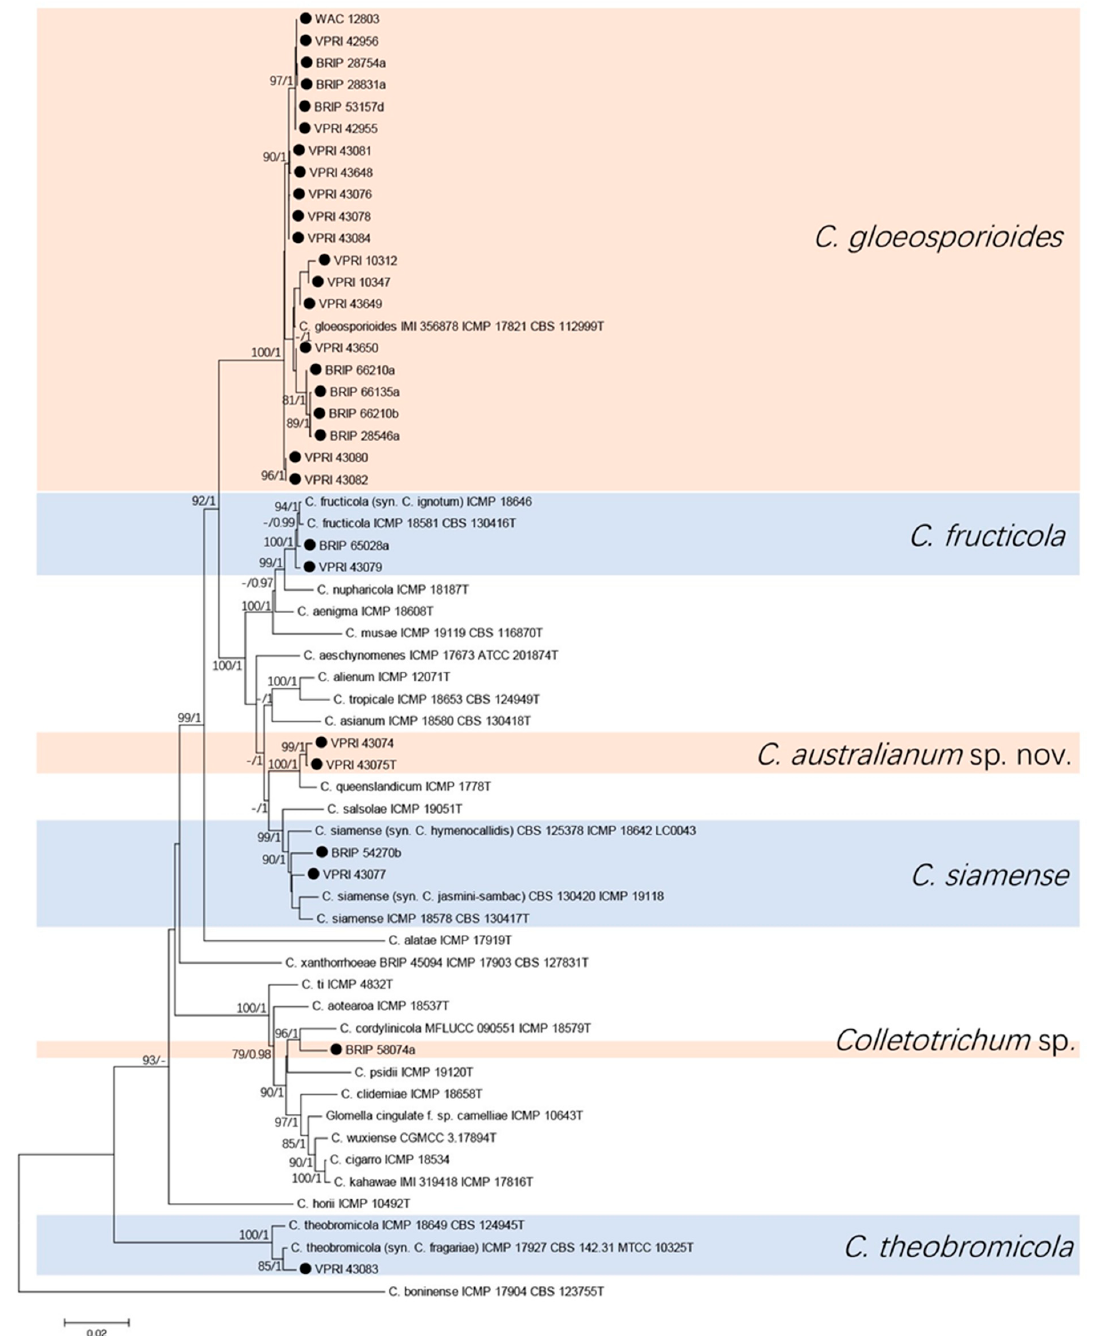
Figure 1. Phylogenetic analysis of the combined ITS, gapdh , act , tub2 , ApMat , GS , and chs-1 sequence alignment of Colletotrichum isolates in the gloeosporioides complex. The bootstrap support values (ML > 75%) of maximum likelihood analysis and Bayesian posterior probabilities (PP > 0.90) are displayed at the nodes (ML/PP). Black circle denotes isolates from Citrus spp.